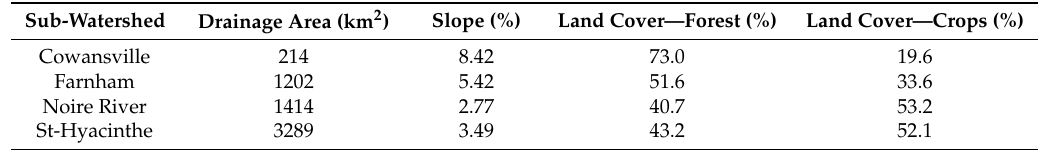
Table 1. Physiographic characteristics of the study